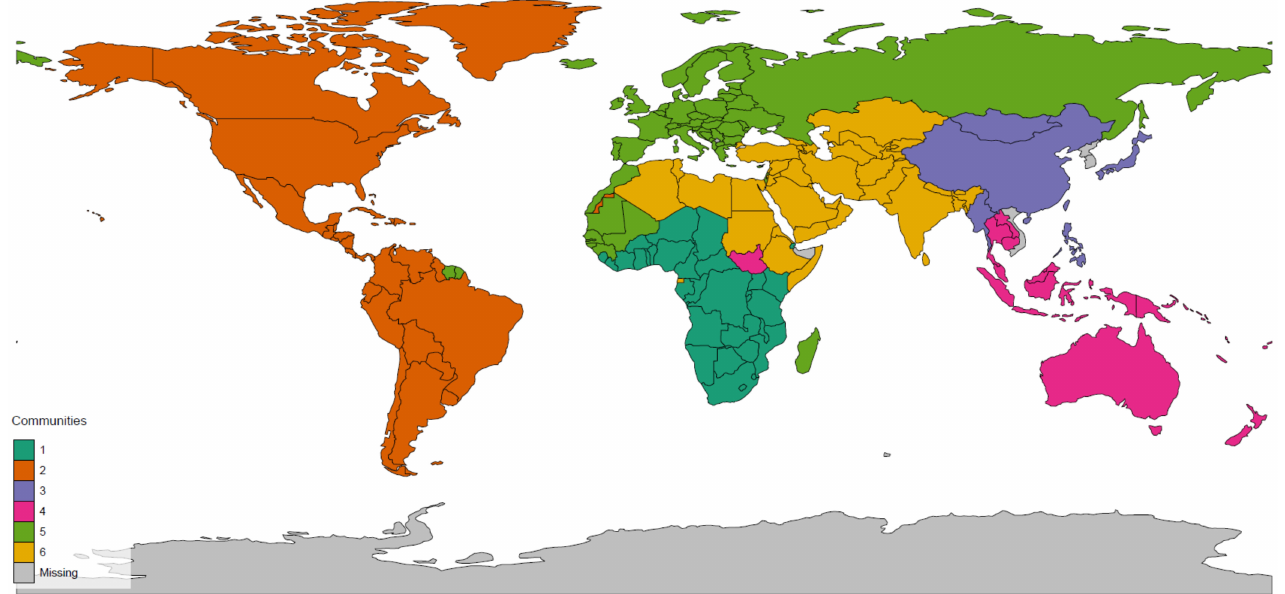
Figure 6. Communities in the world tourism network. Source: